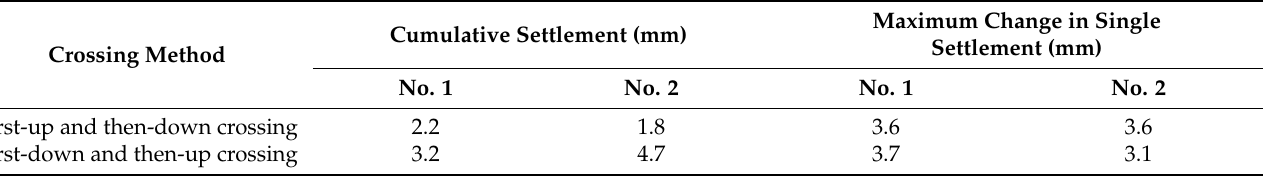
Table 3. Longitudinal deformations of existing tunnels under two kinds of crossing